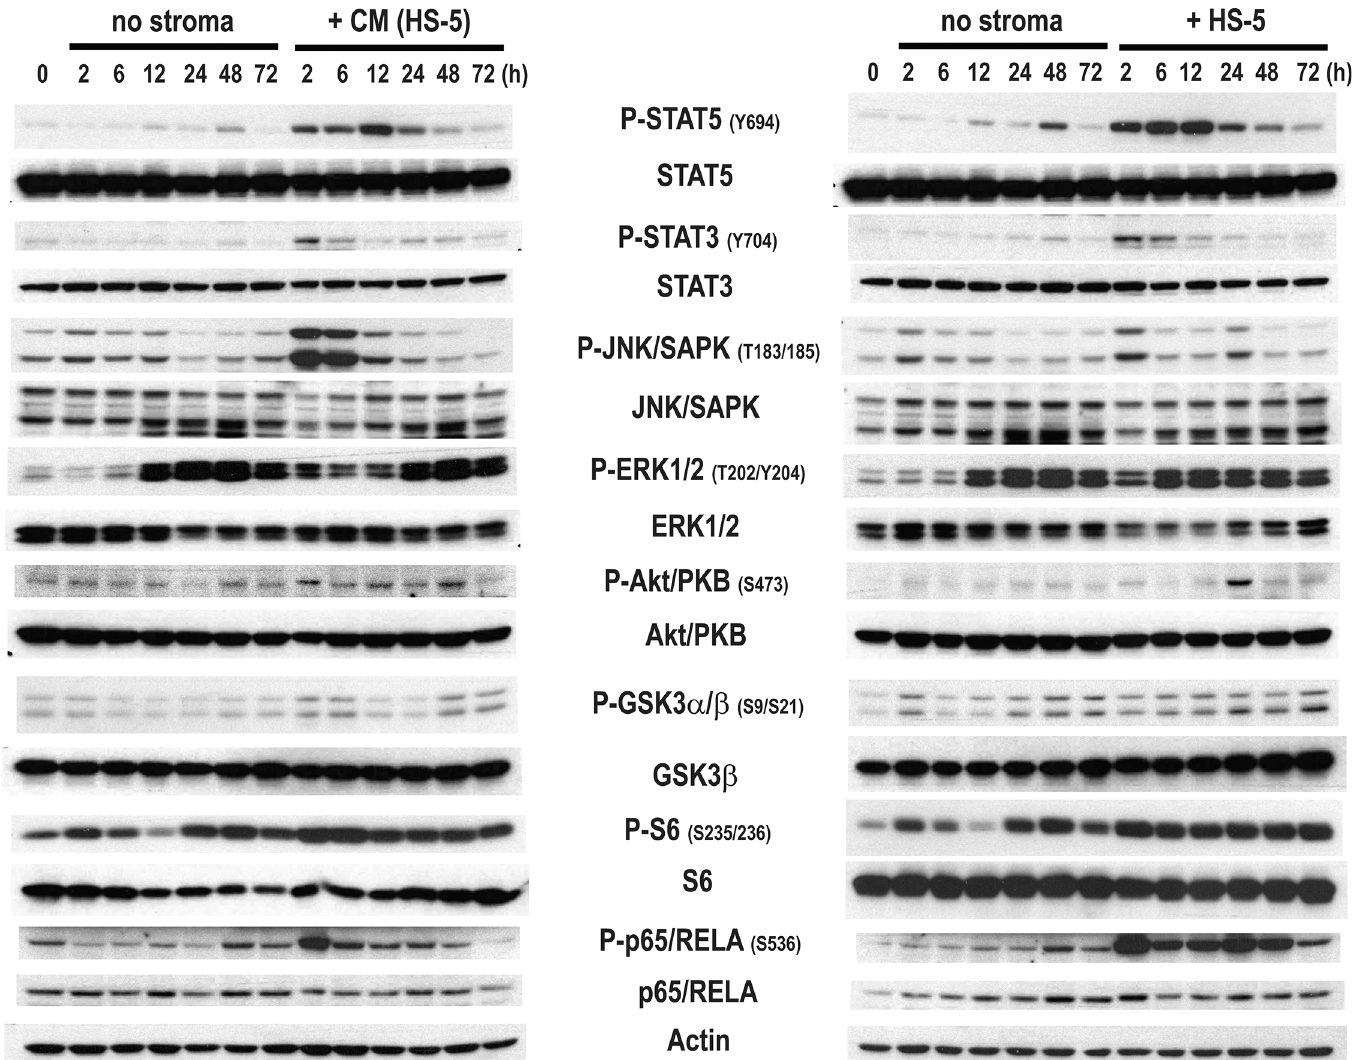
Fig 2. HS-5 stroma activates crucial signalling pathways in SET-2 cells. SET-2 cells were cultured in vitro (no stroma), co-cultured in a stromal layer of HS-5 cells (+ HS-5) and with HS-5 conditioned media [+ CM (HS-5)] at the indicated time point the cells. Cells were lysed and the phosphorylation and total levels of STAT5, STAT3, JNK/SAPK, ERK1/2, Akt/PKB, GSK3 α / β , S6 and p65/RELA were analyzed by immunoblot. Actin was used as loading control. The data is representative of two independent